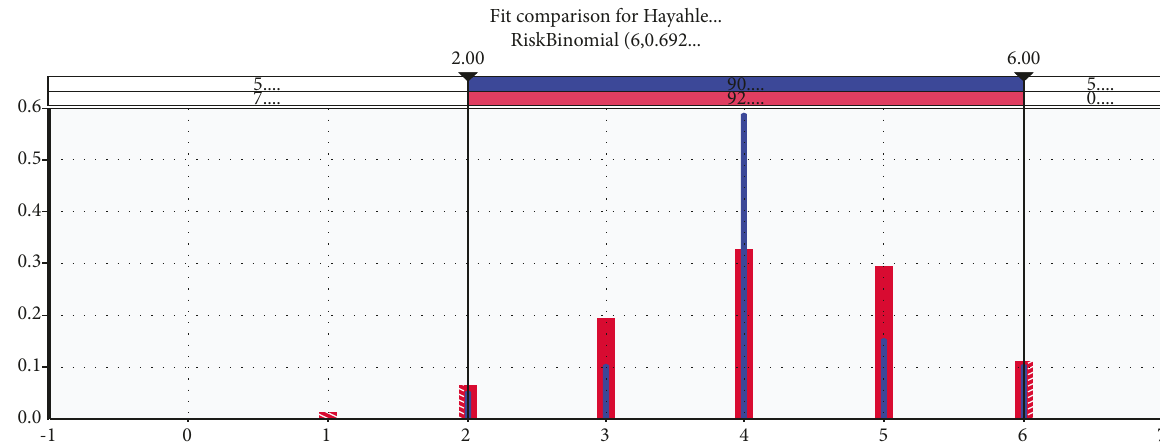
Figure 3: The probability distribution of hourly tramcar arrival for peak hours at Haya Hulet 1 station in the E-W